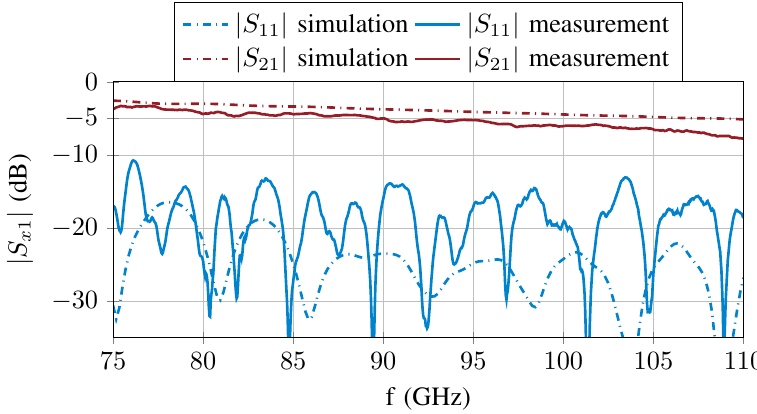
Figure 8. Measured and simulated S-parameters of the tunable sWL fibre phase